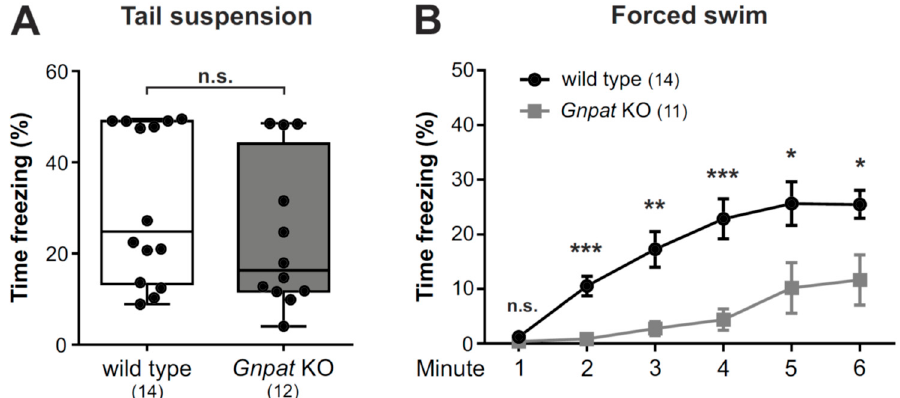
Figure 5. Prominent changes in the forced swim paradigm but not the tail suspension test in ether lipid-deficient animals: ( A ) WT and Gnpat KO mice were examined in the tail suspension test, and the duration of the freezing response is shown as box plot with whiskers indicating minimal and maximal values. Statistical analysis was performed using two-tailed Student’s t -test. ( B ) The duration of immobility of WT and ether lipid-deficient mice was quantified in each minute of the forced swim test. Results are shown as mean ± standard error of the mean (SEM), and statistical analysis was performed using two-tailed Student’s t -tests followed by Holm–Sidak correction for the repeated measurements. The number of tested animals is given in brackets. *** p < 0.001, ** p < 0.01, * p < 0.05; n.s. , not significant .